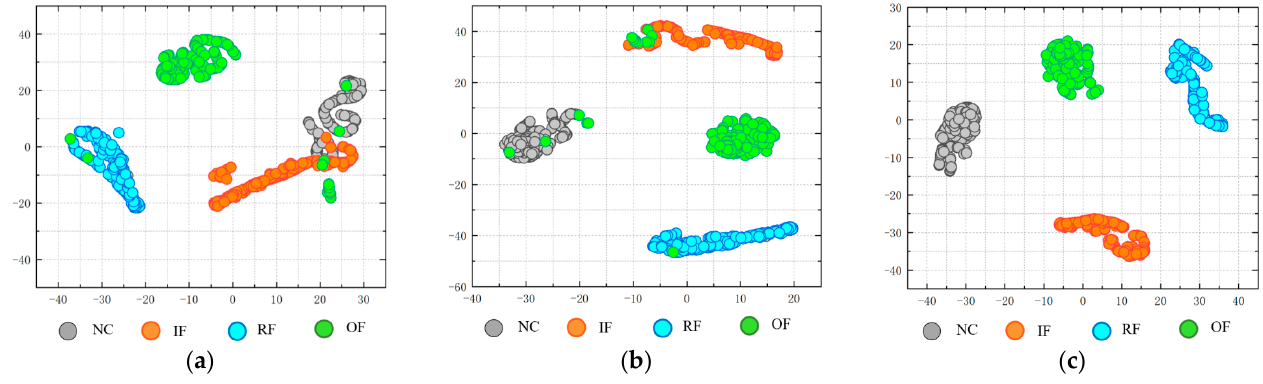
Figure 12. Dimensionality reduction visualization results on dataset B: ( a ) GAN. ( b ) WGAN. ( c ) WGAN-GN.